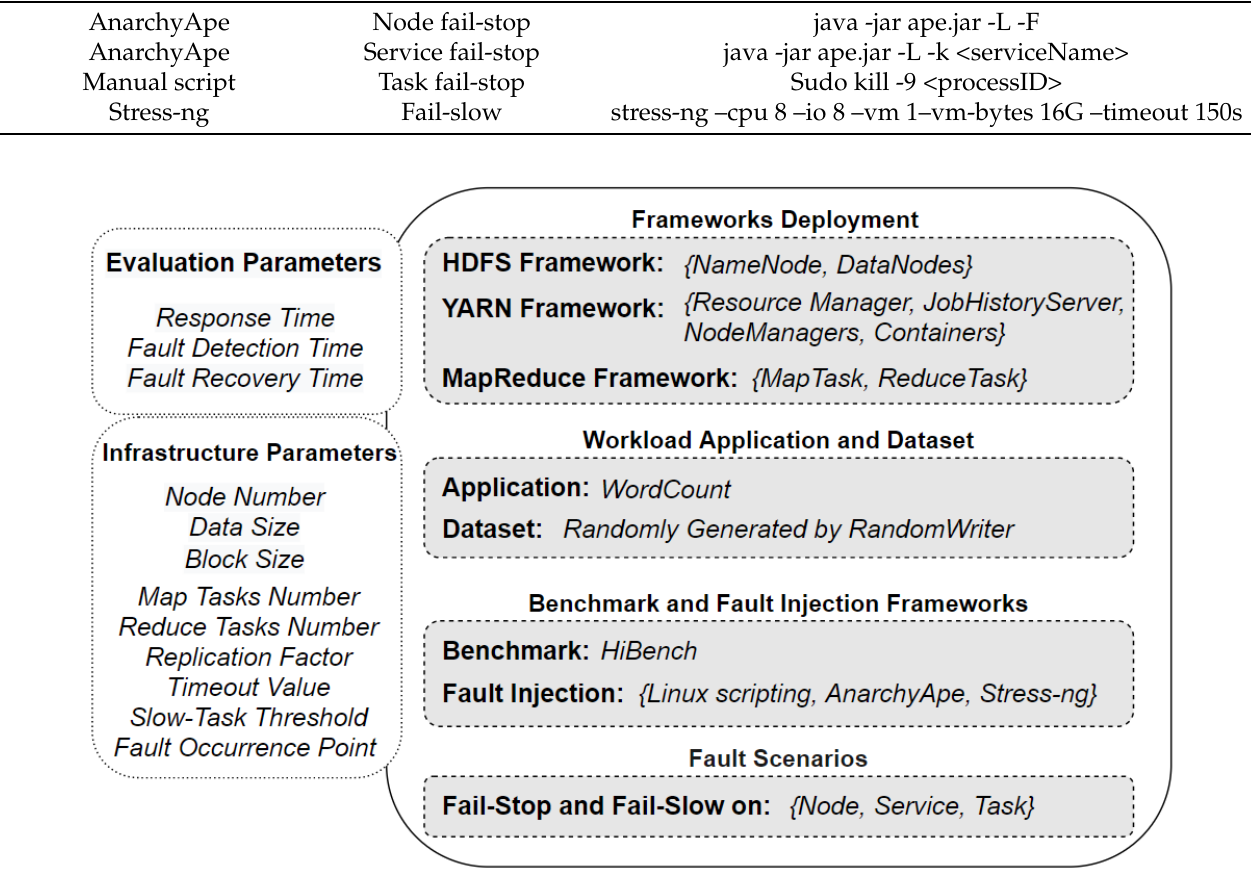
Figure 3. The main parts of the experimental